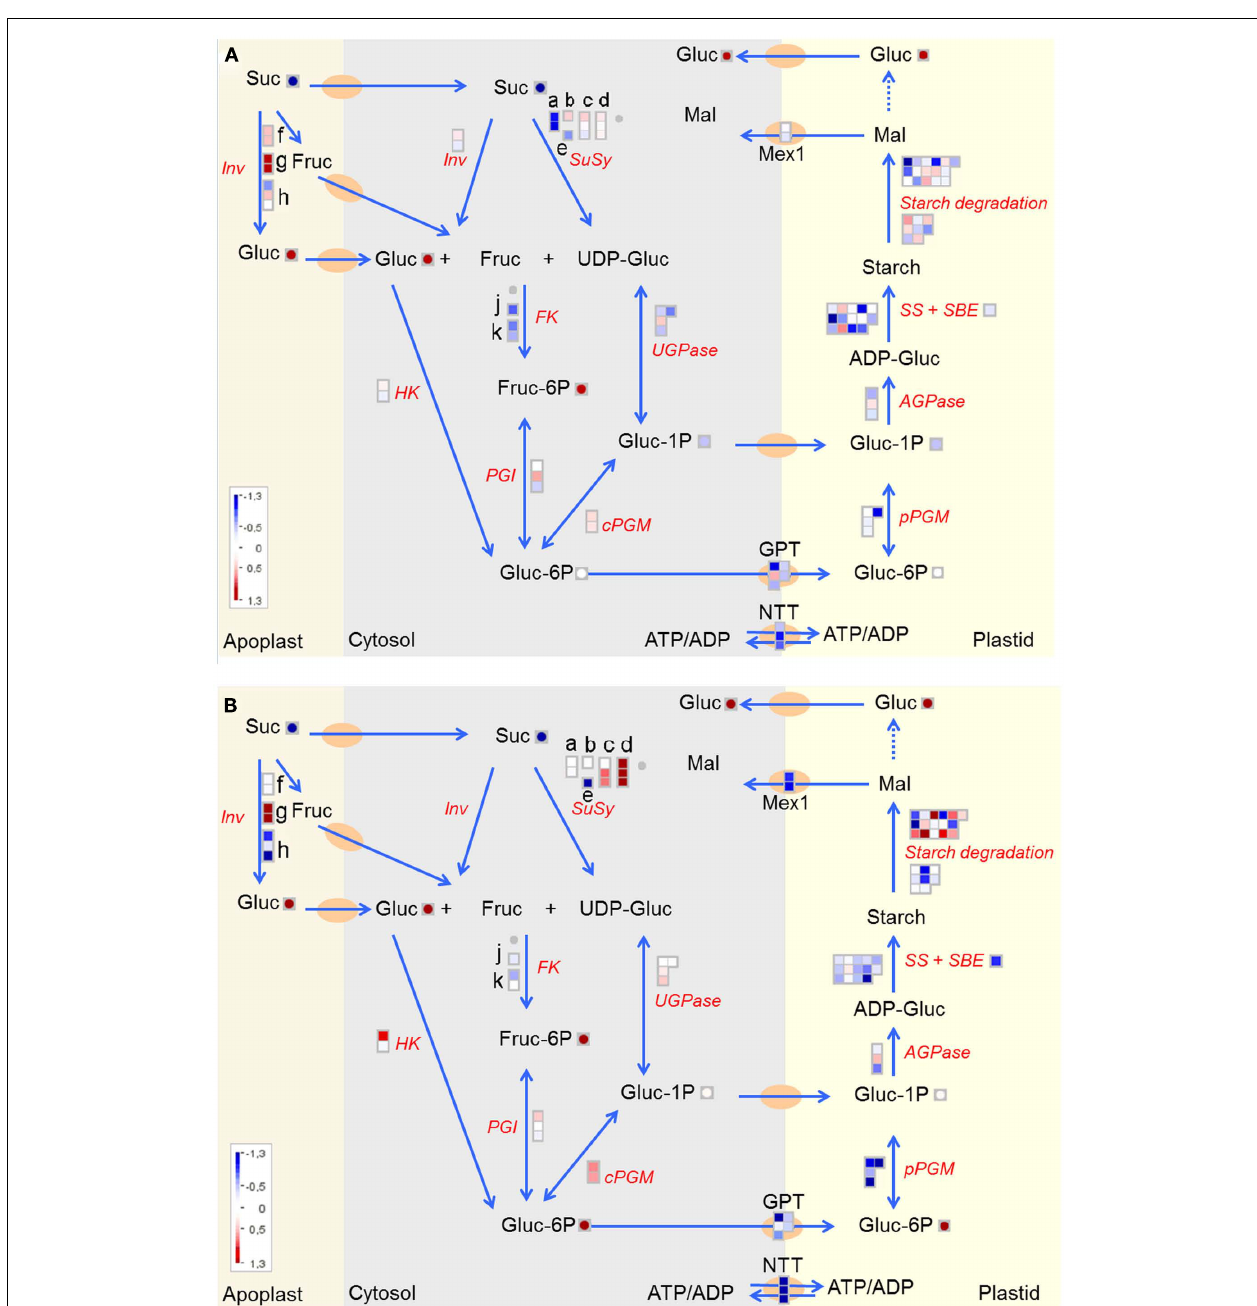
FIGURE 6 | Starch biosynthesis with sucrose as primary substrate in (A) U-IN-1 and (B) U-IN-2. Different subunits of Susy are represented by (a–e) with (a) Susy4. (f–h) Represent the differentially expressed cell wall invertase